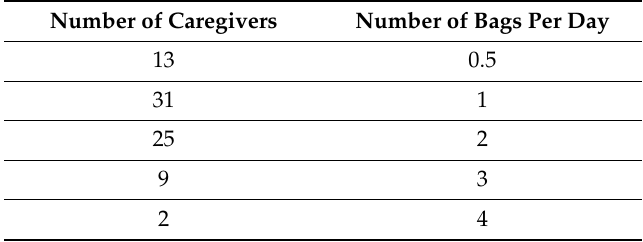
Table 1. Quantity of health care risk waste generated by caregivers per